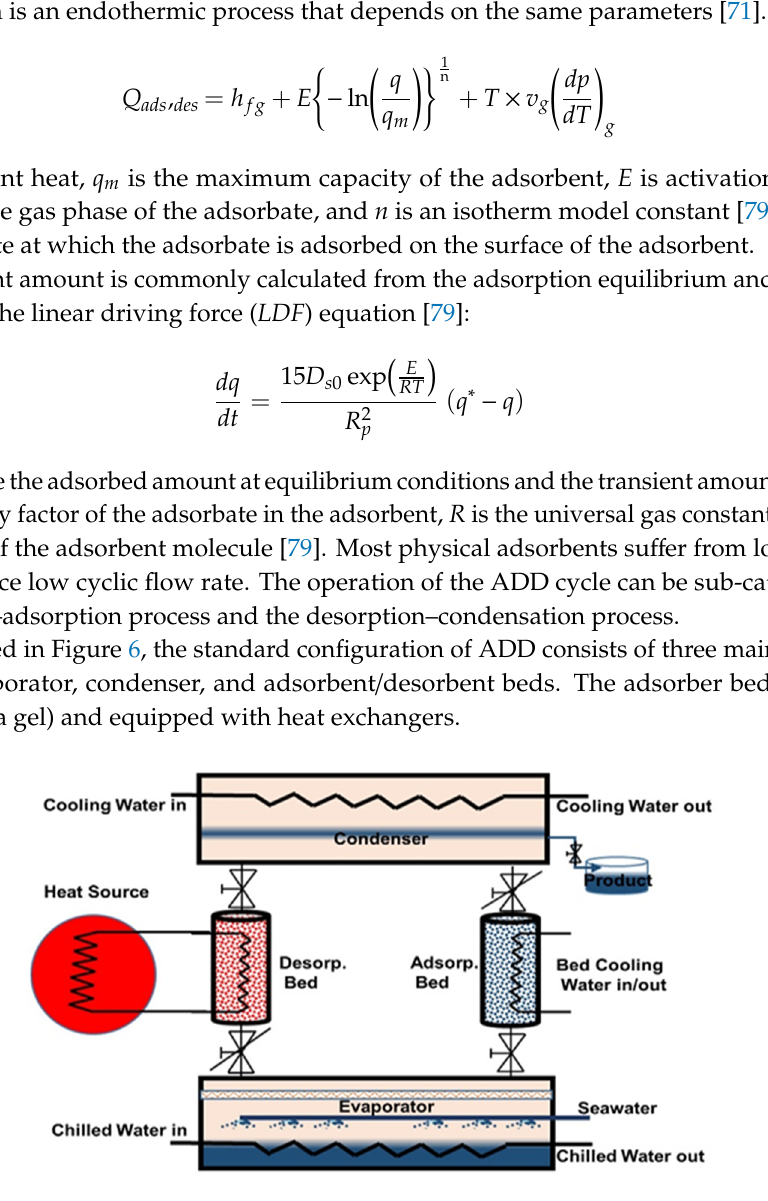
Figure 6. Main components of standard configuration of ADD.